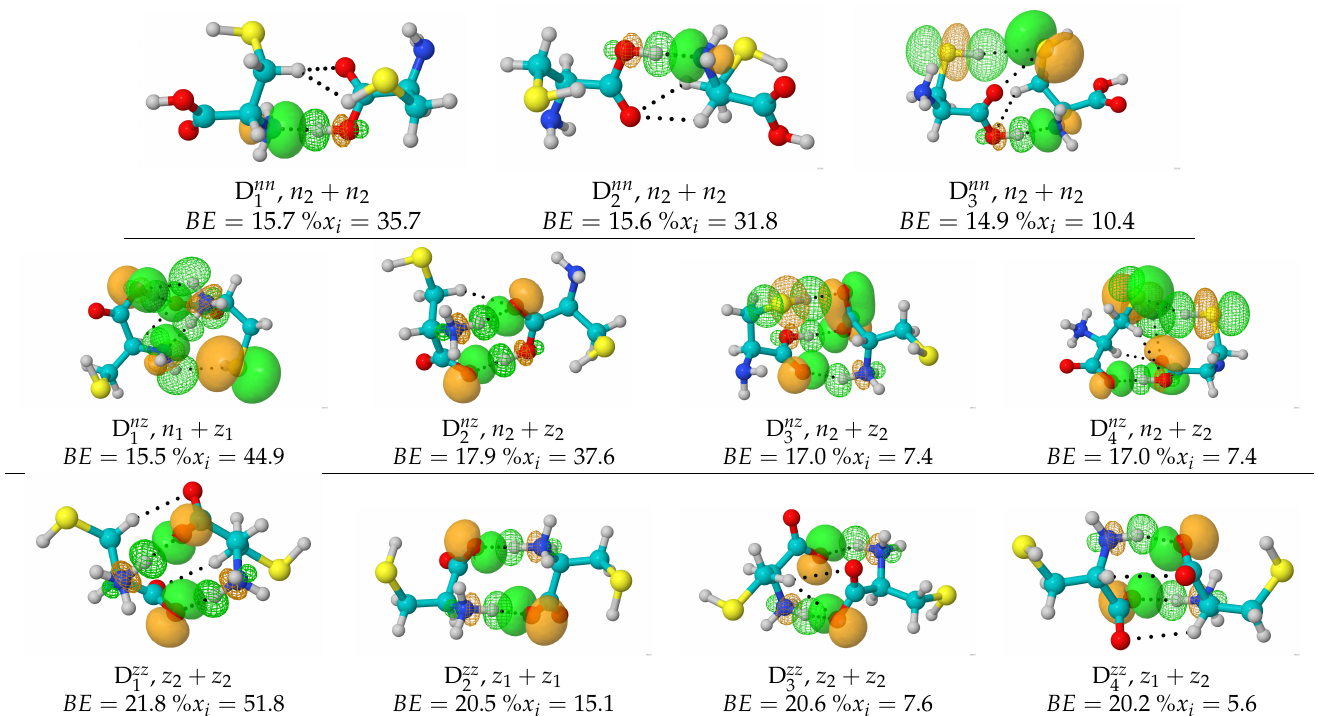
Figure 1. Lowest energy structures and the NBOs responsible for the strongest intermolecular interactions in the neutral n · · · n (top), neutral + zwitterionic n · · · z (middle) and zwitterionic z · · · z (bottom) B3LYP–D3/6–311++g( d , p ) potential energy surfaces of the cysteine dimers under the continuum IEFPCM solvent model for water. Solid/meshed surfaces correspond to charge donor/acceptor orbitals, respectively. BE : binding energies in kcal/mol calculated using the Gibbs free energies at room conditions. See Table 1 for the structures of n 1 , n 2 , z 1 , z 2 , the isolated monomers. Only those structures with populations (% x i ) higher than 5% within each PES are included.